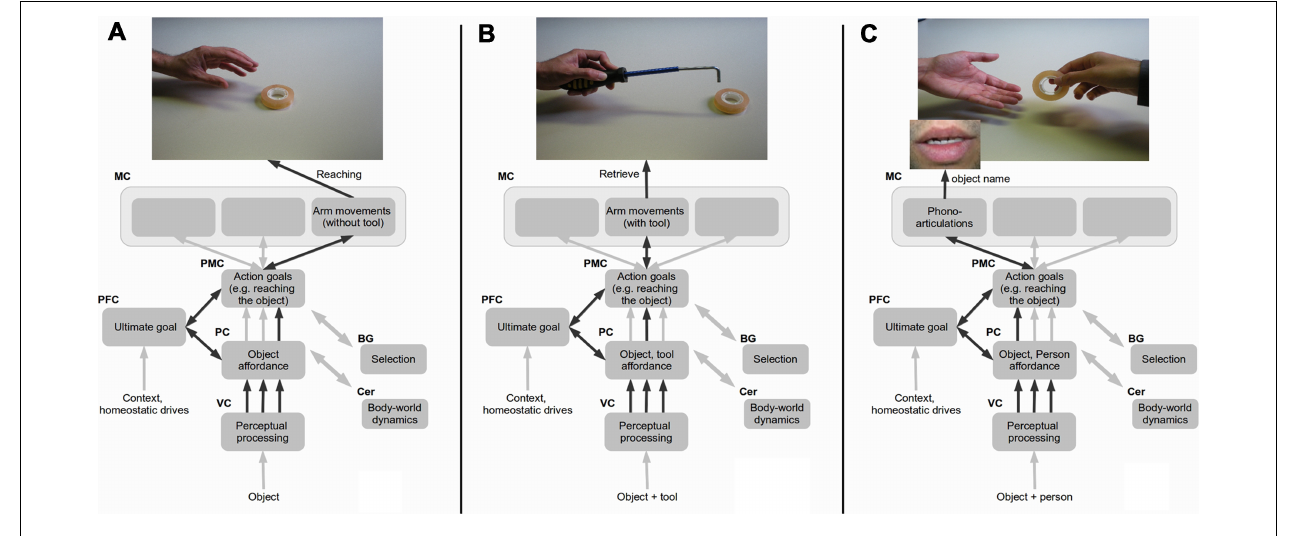
simulate body-world, dynamics; cortico-basal ganglia (BG) loops underlie action and affordance selection processes. (A–C) represent a possible progression of development of representations from body actions, to tool-mediated actions and words-as-tool actions, all relying on the same macro brain areas and on partially overlapping local neural modules (cell assemblies). Multiple PC-PMC arrows represent multiple affordance-action options and the black arrow the most active within